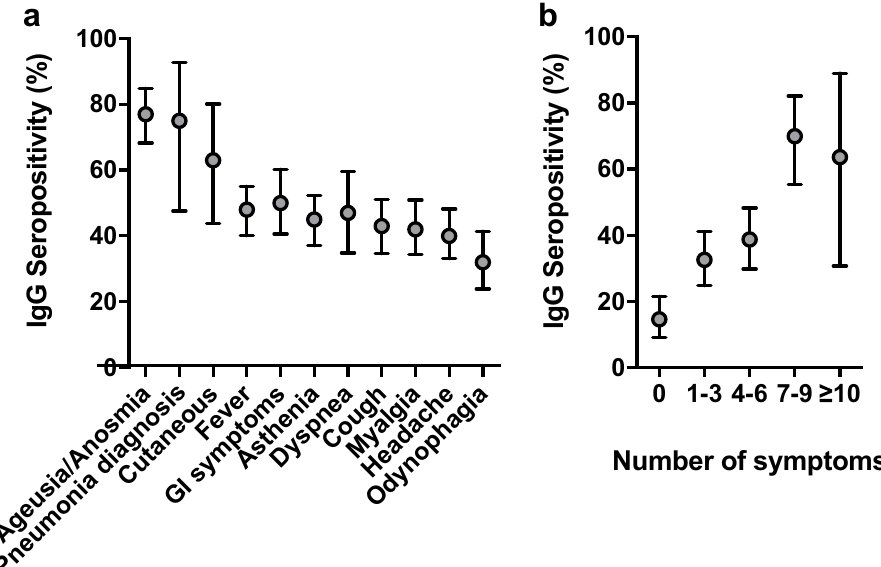
Figure 2. IgG seropositivity for SARS-CoV-2 by COVID-19 compatible symptoms and diagnosis. ( a ) IgG seropositivity associated with each of the reported symptoms or diagnosis. ( b ) IgG seropositivity grouped by the number of individual symptoms/diagnoses reported. Dots and vertical lines represent the mean and 95% confidence interval, respectively. GI,